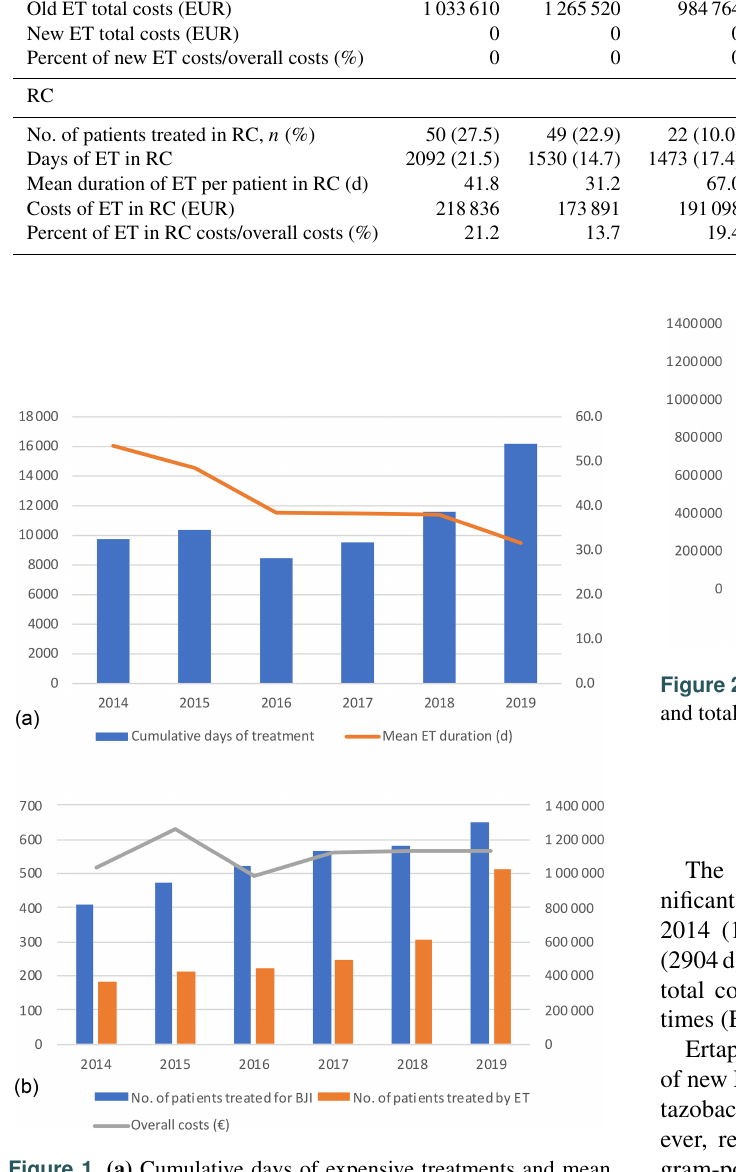
Figure 1. (a) Cumulative days of expensive treatments and mean duration. (b) Number of patients treated (blue) in the referral cen- tre with expensive treatment (orange) and global costs (line). ET – expensive treatment; BJI – bone and joint infection.